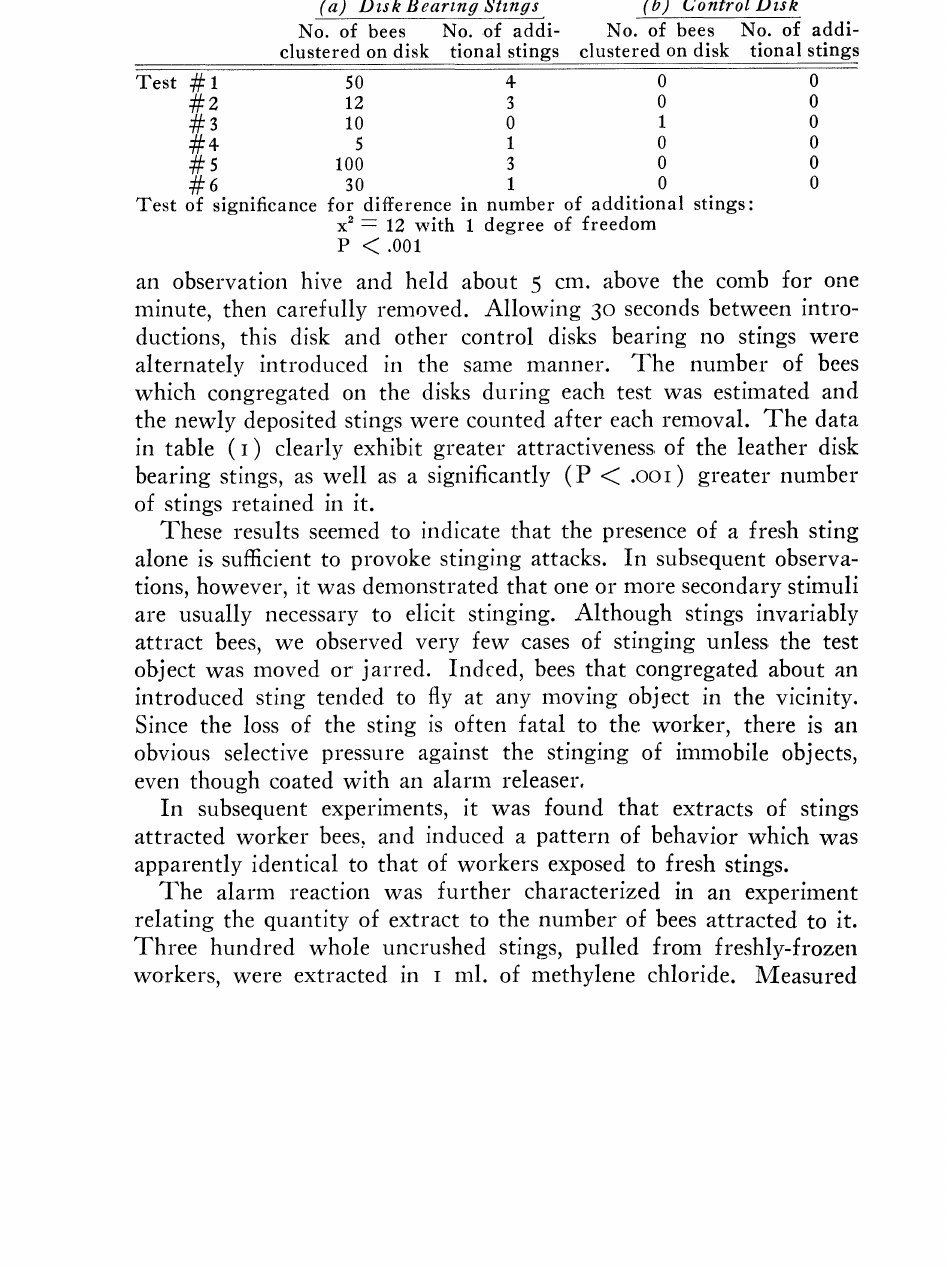
TABLE 1. Response to suede leather disk bearing three fresh stings compared to response to an untreated control disk. (a) Disk Bearing Stings (b) Control Disk No. of bees No. ,of addi- No. of